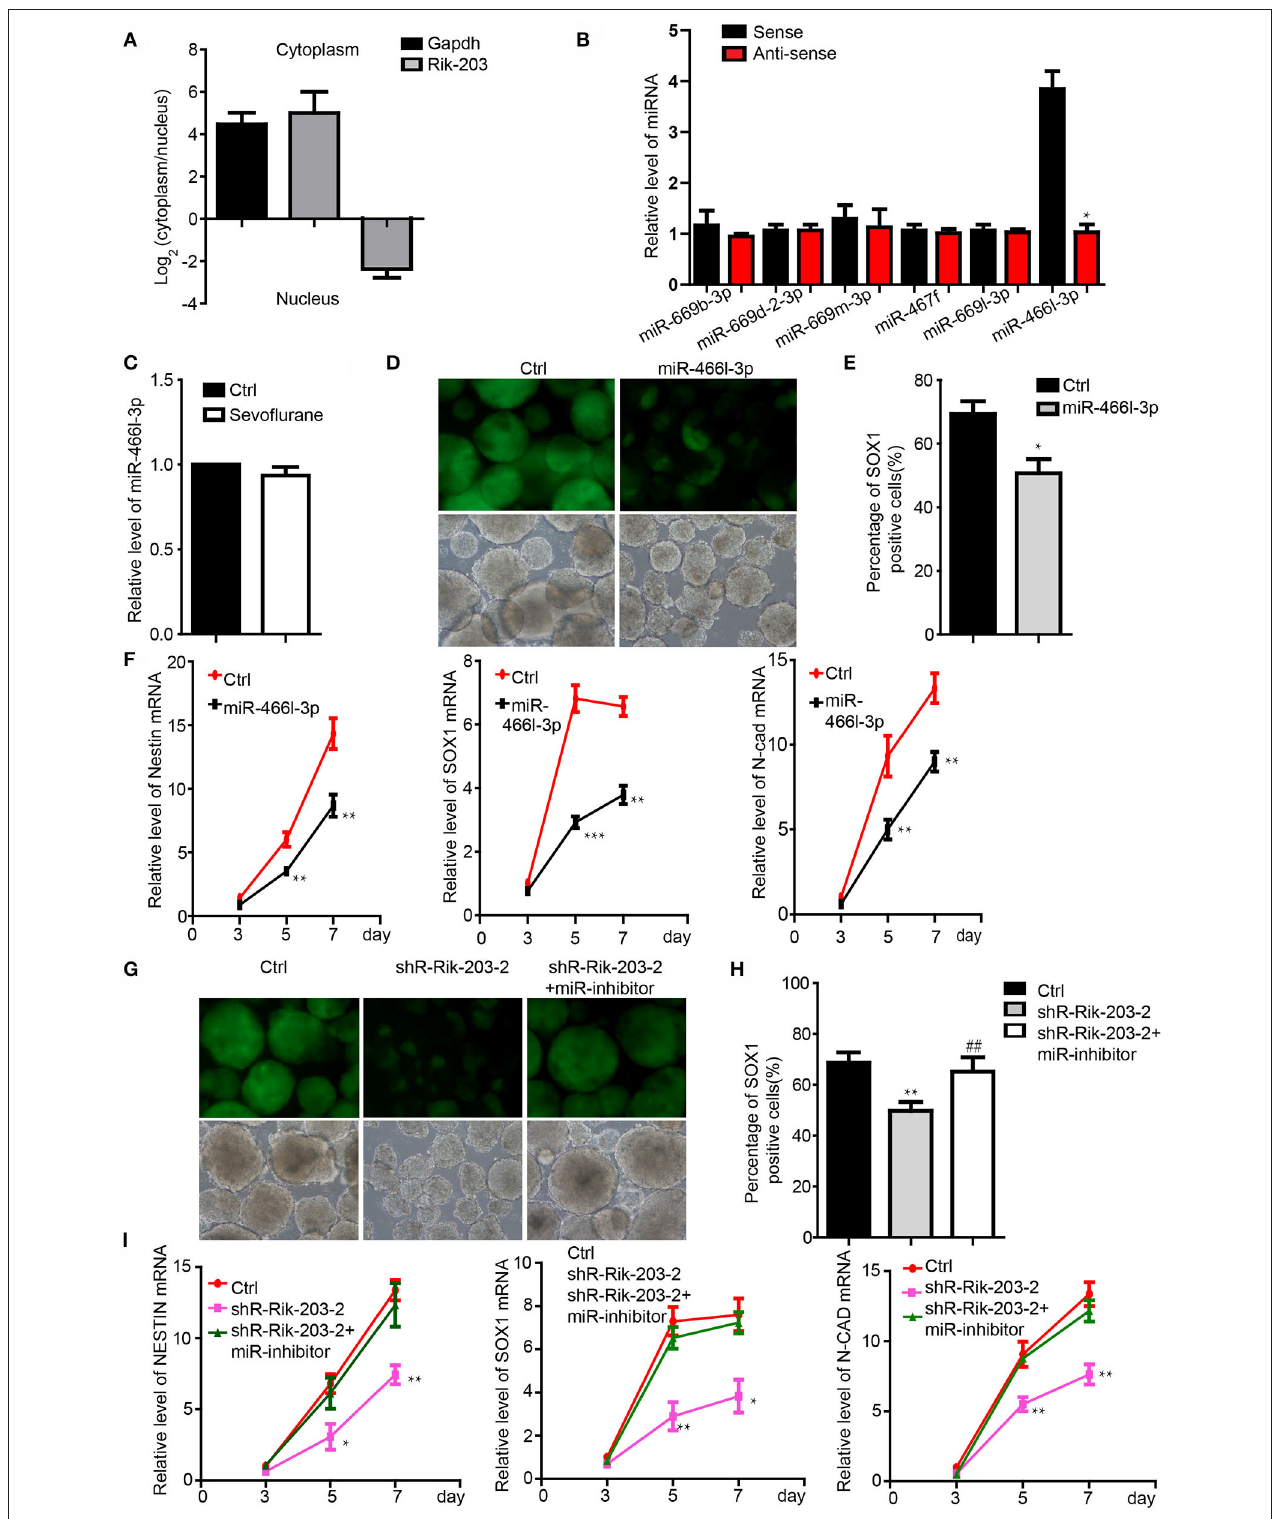
FIGURE 2 | Rik-203 targeted the miR-466l-3p during the neural differentiation. (A) Cytoplasmic and nucleus distribution of Rik-203 was detected by RT-PCR and showed that there were higher Rik-203levels in the cytoplasm. (B) RNA pull-down assay showed that miR-466l-3p bind to Rik-203. (C) Sevoflurane could not affect